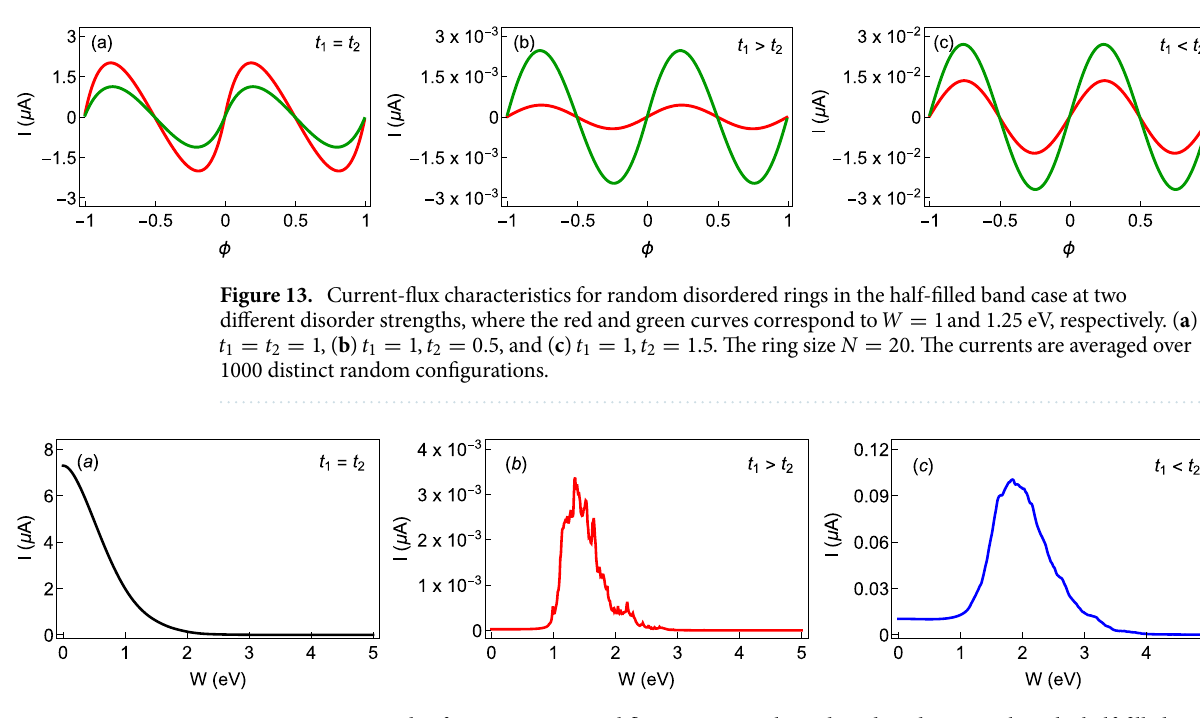
Figure 14. Magnitude of current, at a typical flux φ = 0.2 , with random disorder strength in the half-filled band case. ( a ) t 1 = t 2 = 1 , ( b ) t 1 = 1 , t 2 = 0.5 , and ( c ) t 1 = 1 , t 2 = 1.5 . The ring size N = 20 . The currents are averaged over 1000 distinct random